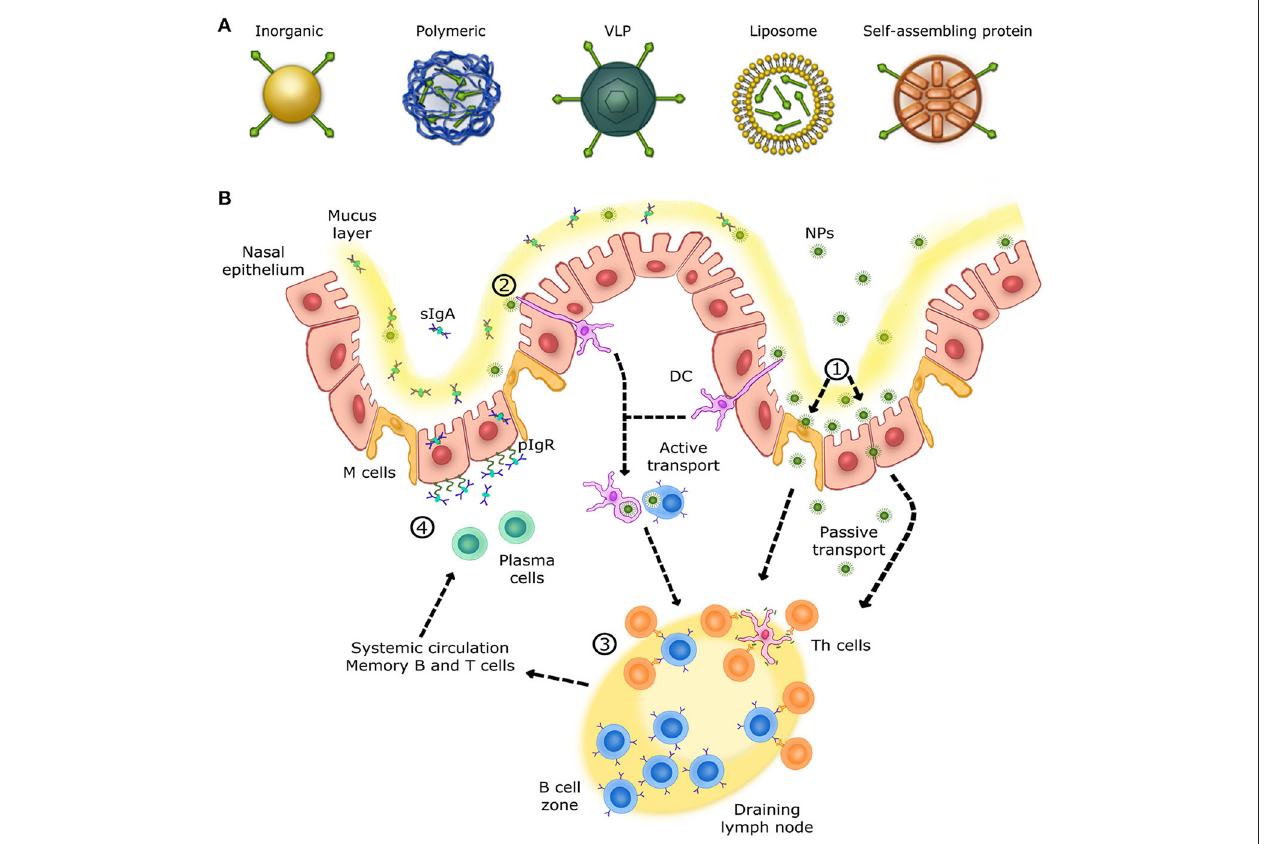
FIGURE 1 | Overview of the immune response in the upper respiratory tract. (A) Schematic view of different nanoparticles used for intranasal vaccination. (B) Mechanisms of NALTs immune responses in the upper respiratory tract. (1) Nanoparticles are transcytosed from the mucus layer into the nasal epithelial tissues by micro-fold cells (M cells) or passively diffuse through epithelial cell junctions. (2) Other nanoparticles are captured and internalized by DCs (dendritic cells) from their extension through epithelial junctions and by other APCs, such as B cells. (3) Cells that have encountered nanoparticles migrate to the nearest lymph node in order to activate naive T helper cells. Once activated, T helper cells activate B cells that have encountered the same antigen presented by nanoparticles. Activated B cells proliferate in the lymph node (B cell zone) and, once mature, enter systemic circulation in order to reach the inflammation site. IgA + B cells locally differentiate into antibody-secreting plasma cells to produce IgA dimers. (4) IgA dimers are secreted via polymeric Ig receptor (pIgR) at the mucosal surface. NALT immune response induces long-lasting memory B and T cells able to trigger a rapid recall